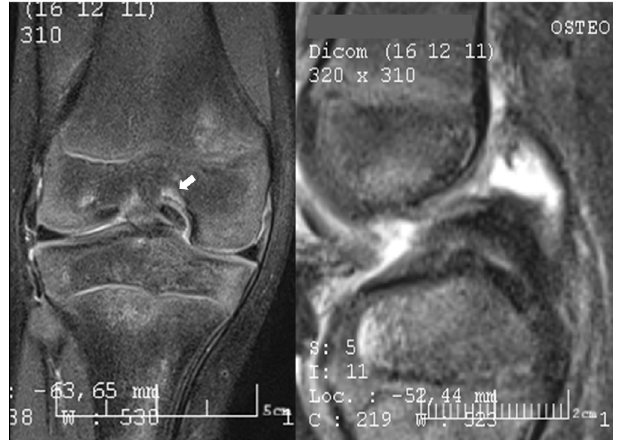
Figure 2. Case 1. MRI aspect after second assessment reveals cartilaginous nodule in the intercondylar notch with femoral oedema in coronal plane (left) and abnormal thickening of the proximal part of the PCL